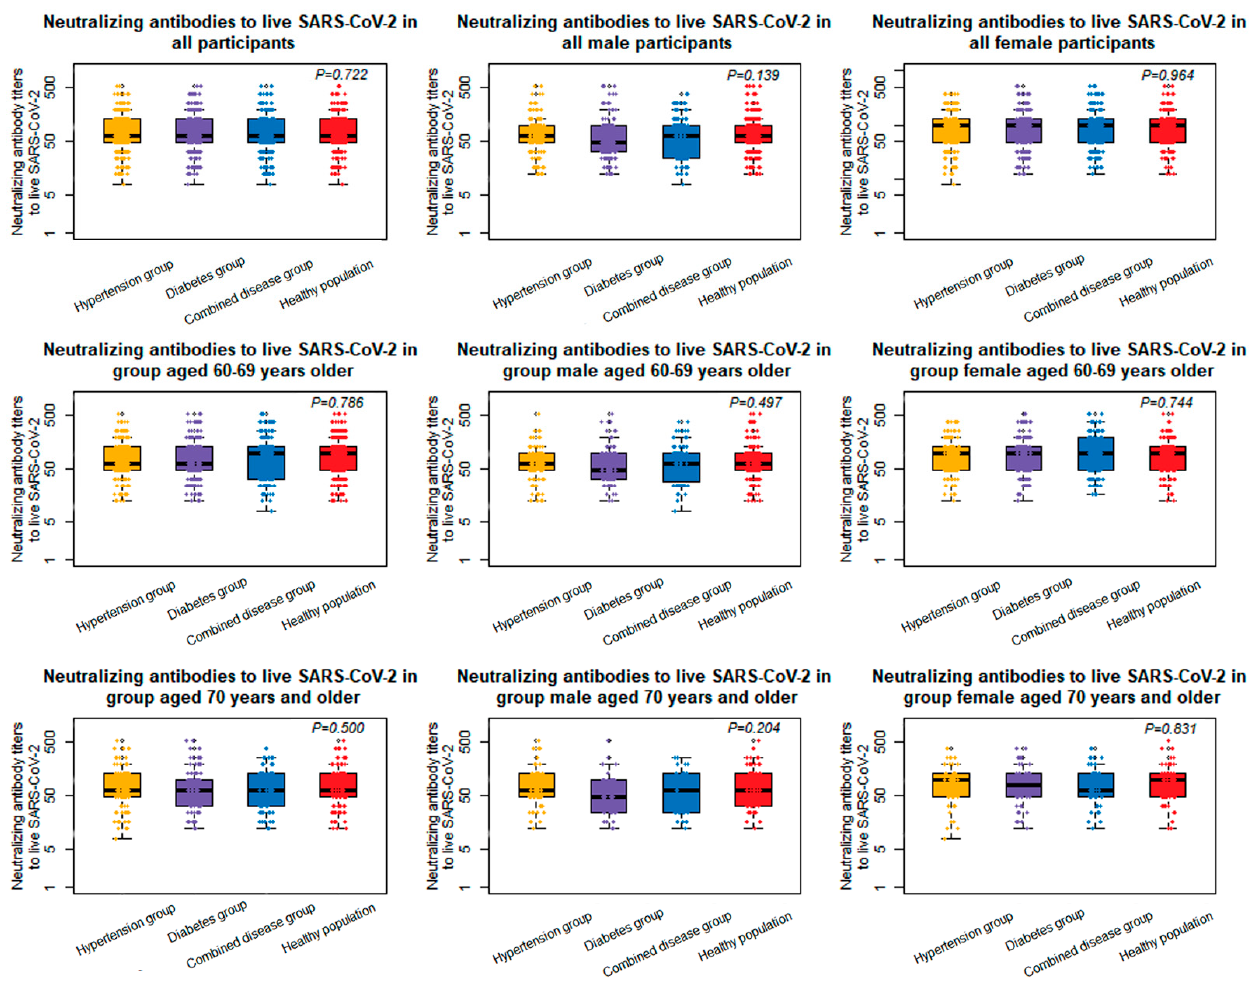
Figure 2. The level of neutralizing antibodies to live SARS-CoV-2 in adults aged over 60 years. Dots are reciprocal neutralizing antibody titers for individuals in the per-protocol population. Only p values of comparisons among four groups were shown (all p values are greater than 0.05).